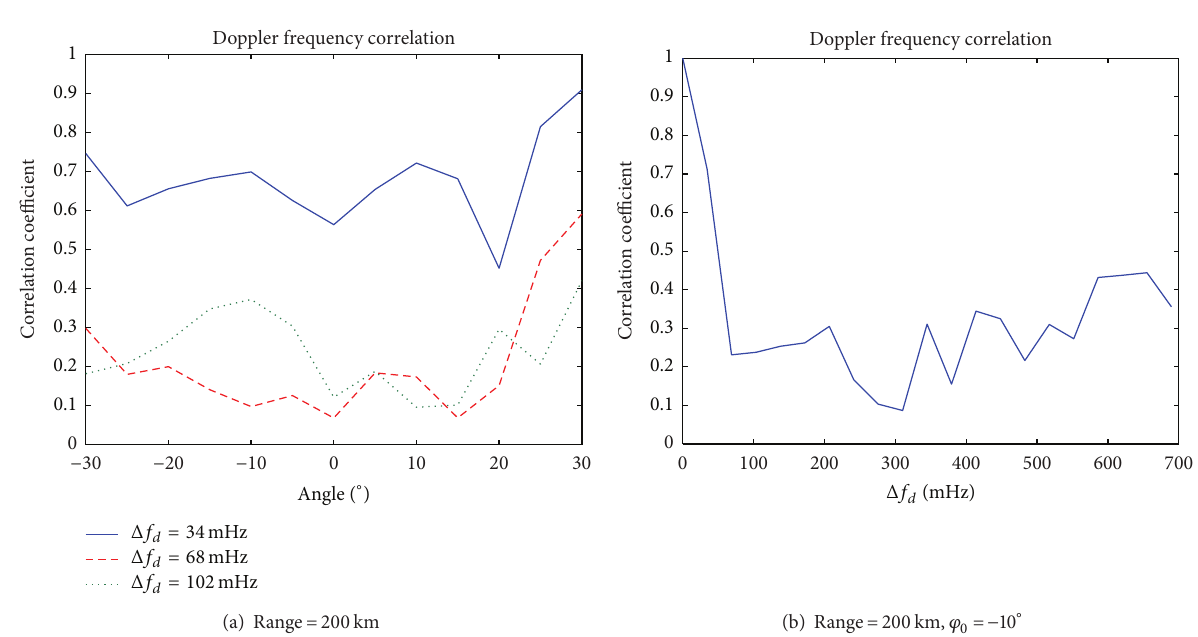
Figure 4: Correlation coefficients with different Doppler shift